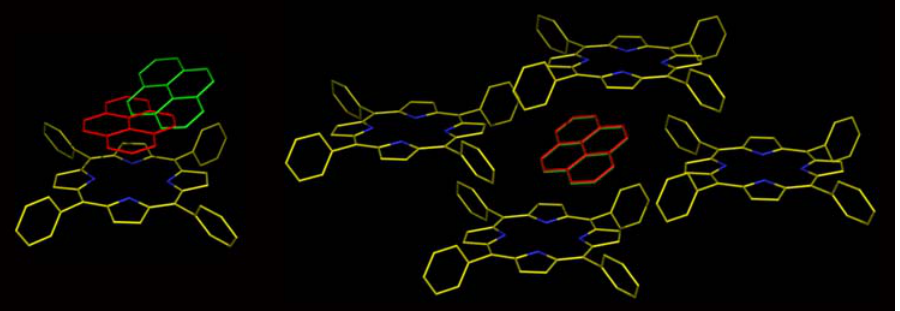
Figure 2. Overlays of the EUDOC-generated and crystal structures of complex XAGMAT. Left: Docking without consideration of the influence of crystal packing. Right: Docking with consideration of the influence of crystal packing. The C atoms of the EUDOC-generated and crystal structure are red and green, respectively. The N atom is blue.